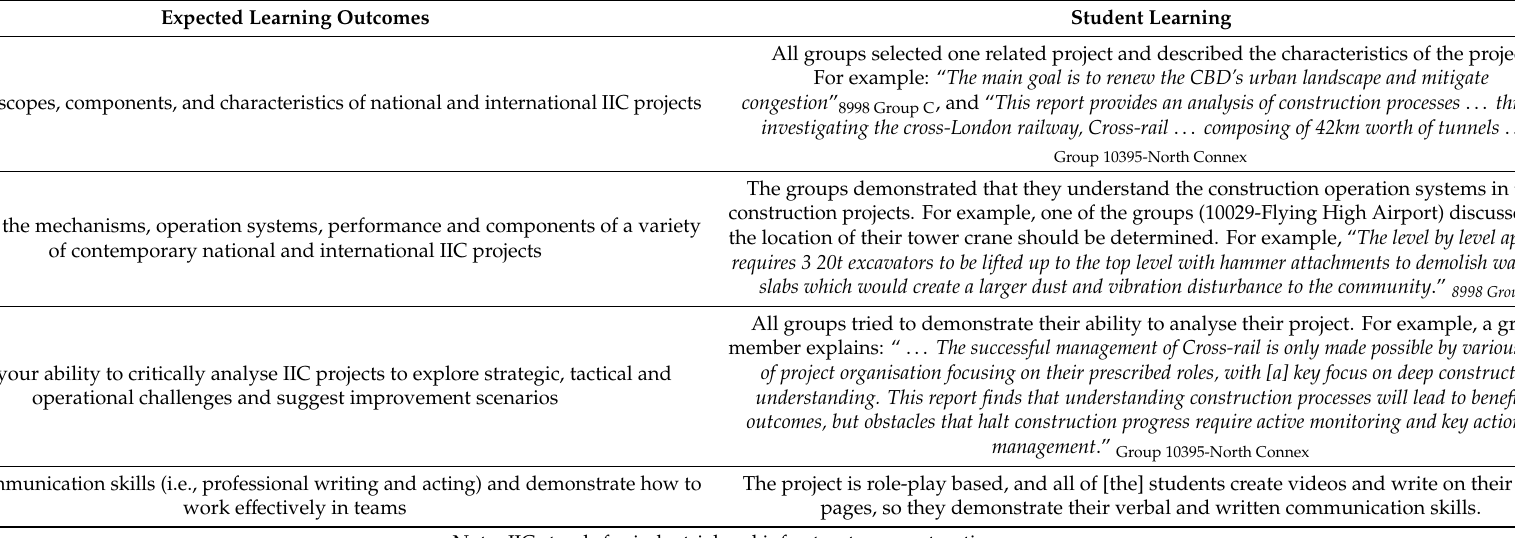
Table 5. Summary of results based on the initial assessment and GWiP